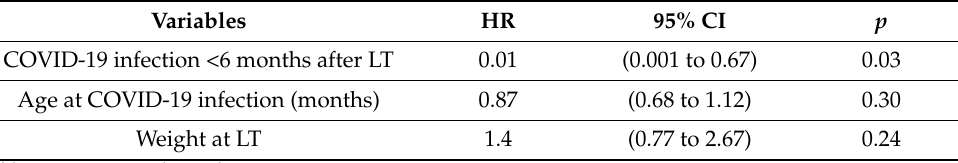
Table 5. Multivariate Cox’s regression analysis for predictors of severe COVID-19 in PLTR.